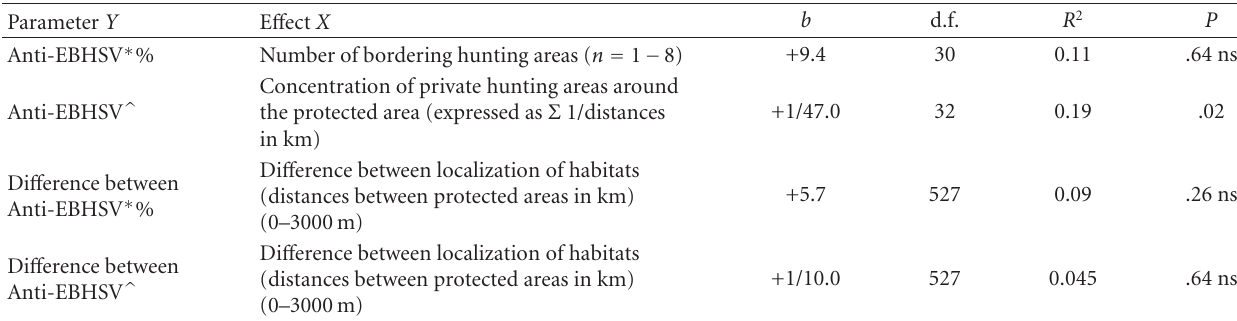
Table 2: Serological data in relation to some geographical